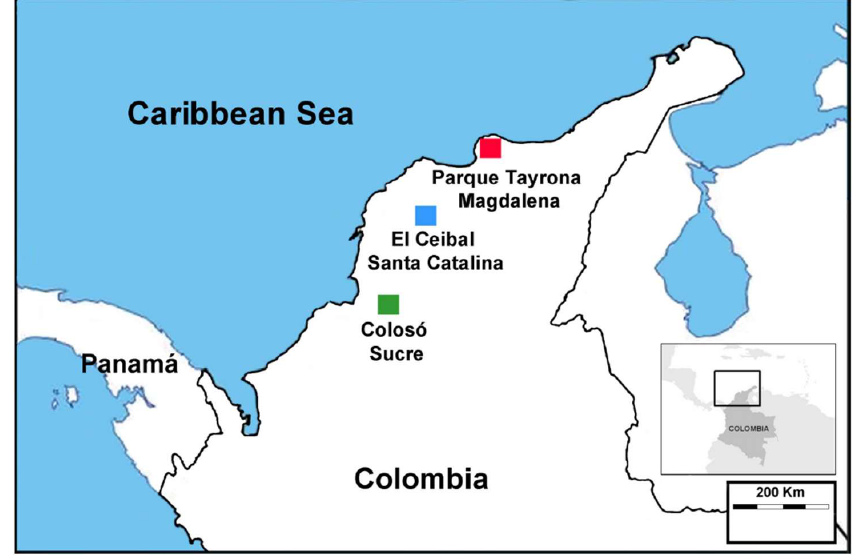
Figure 1. Study sites in Colombia: Reserva forestal de Coraza, Montes de María, Colosó, Sucre (green square); Parque Natural regional Bosque seco El Ceibal Mono Titi, Santa Catalina, Bolívar (blue square); and Parque Nacional Natural Tayrona, Santa Marta, Magdalena (red square).